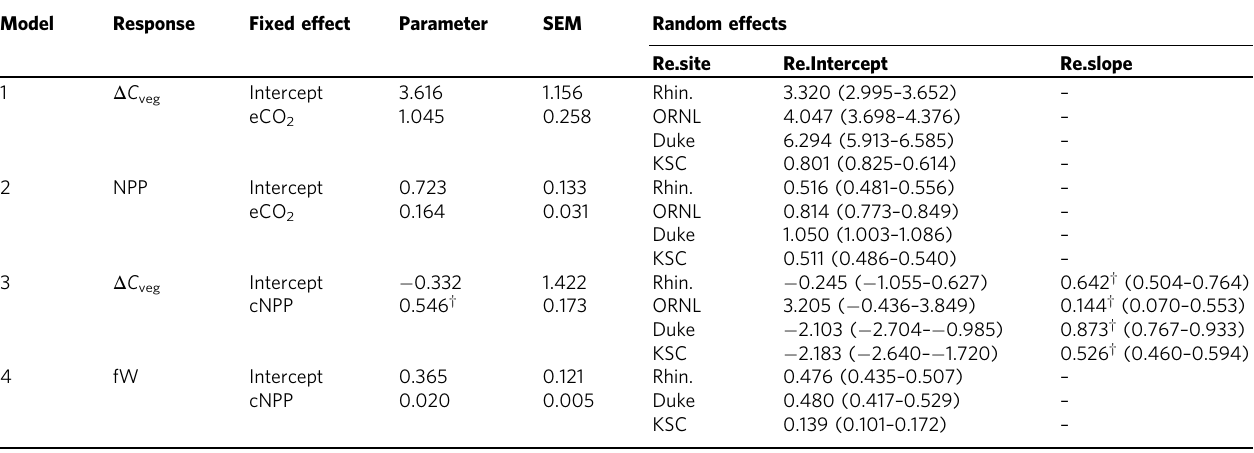
Table 2 Best mixed-effects models Model